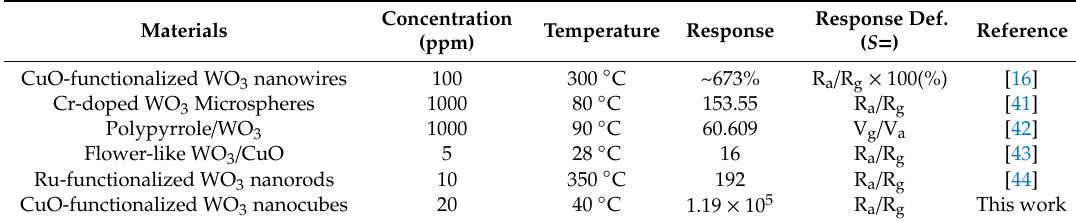
Table A1. A comparison of H 2 S gas sensing performances based on WO 3 -based